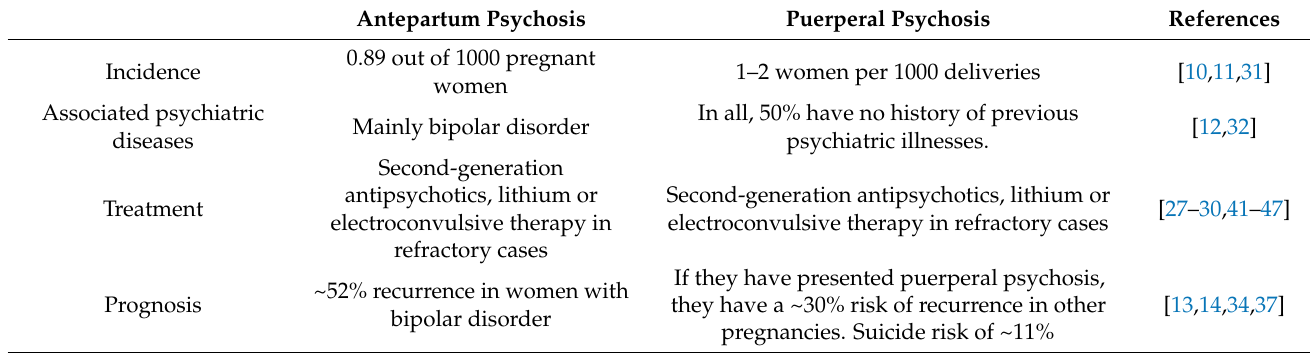
Table 1. Main characteristics of antepartum and puerperal (postpartum)